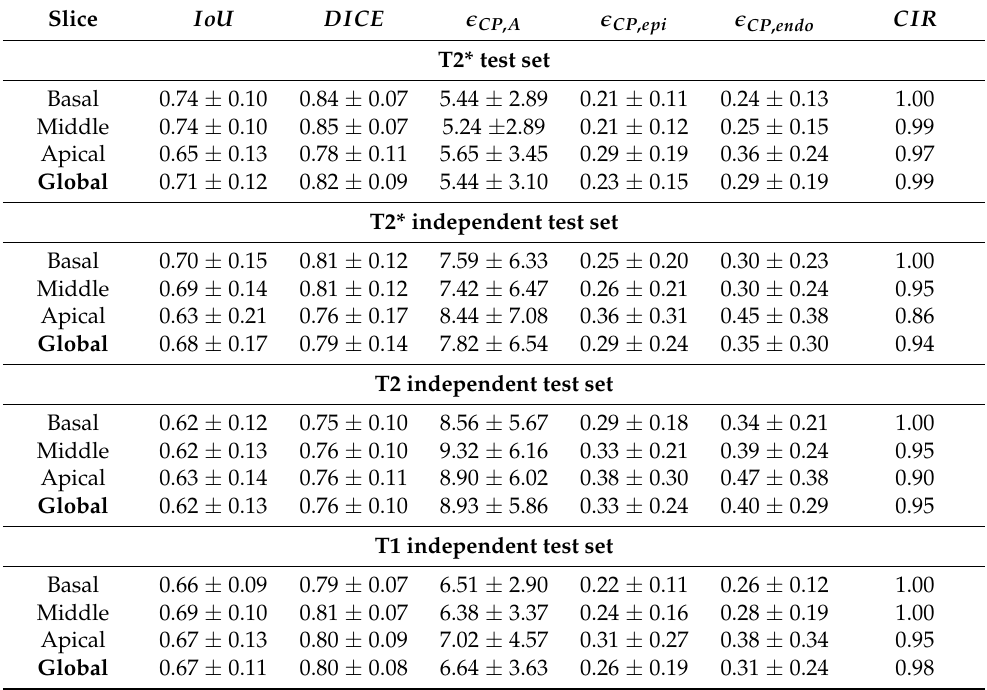
Table 2. Averaged object detection metrics (Mean ± St Dev) over T2* test set, T2* independent test set, T2 independent test set and T1 independent test